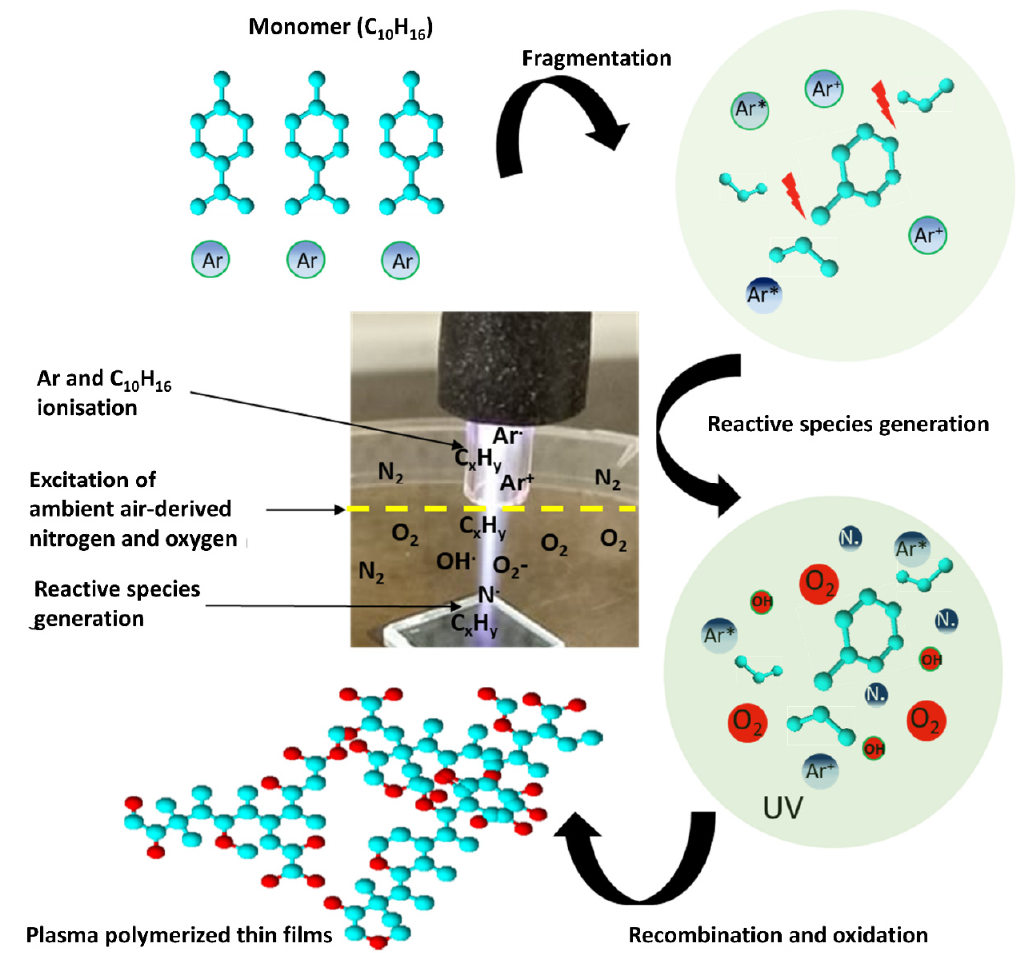
Figure 5. Schematic representation of plasma polymer derived from D-limonene monomer using the APPJ